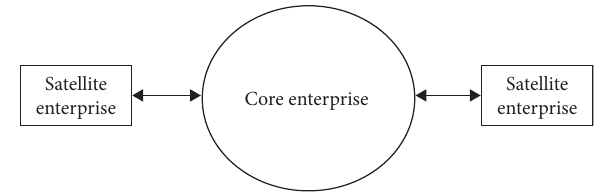
Figure 1: The enterprise cluster with one core enterprise and two satellite